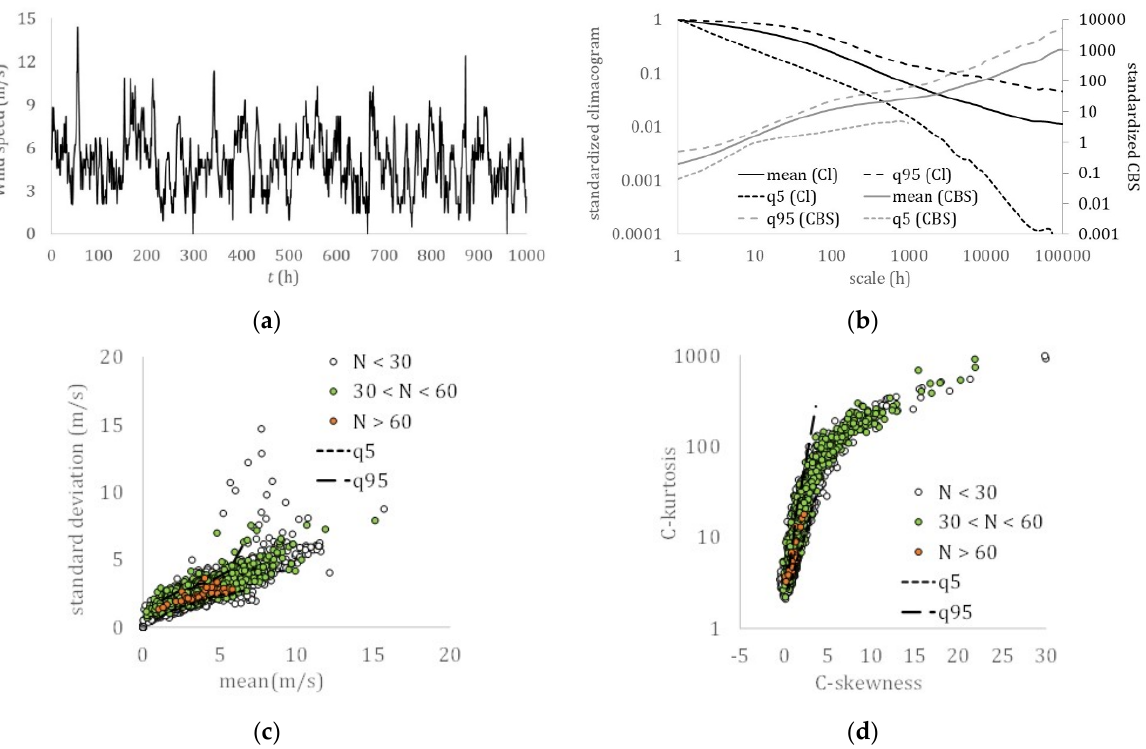
Figure 6. Wind speed: ( a ) hourly sample (Boston, USA); ( b ) climacogram and climacospectrum (mean, and 5% and 95% quantiles); ( c ) mean vs. standard deviation; ( d ) C-skewness vs. C-kurtosis.